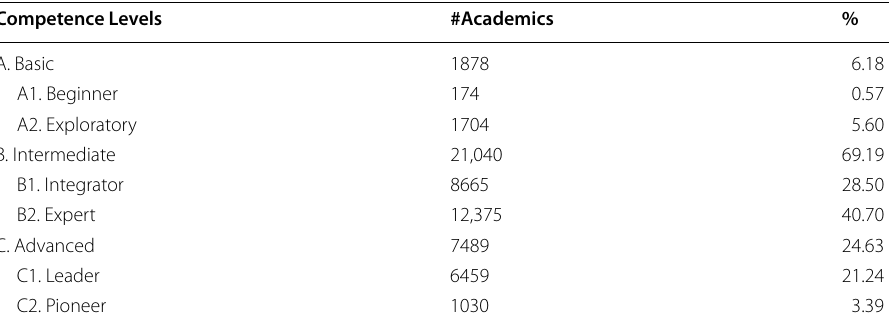
Table 2 Digital-competence level according to the results of the Check-In tool Competence